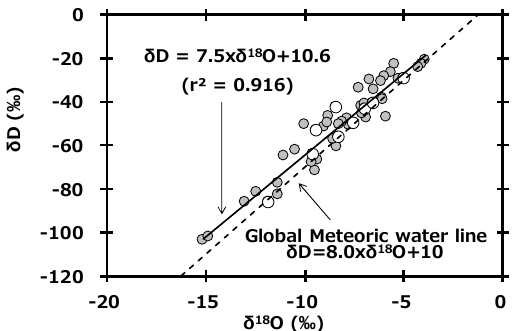
Figure 3. Variations of δ D and δ 18 O in monthly precipitation collected at Toki, Japan with monthly precipitation amount ( A ) and the reported monthly average temperature at the Tajimi AMeDas site ( B ).